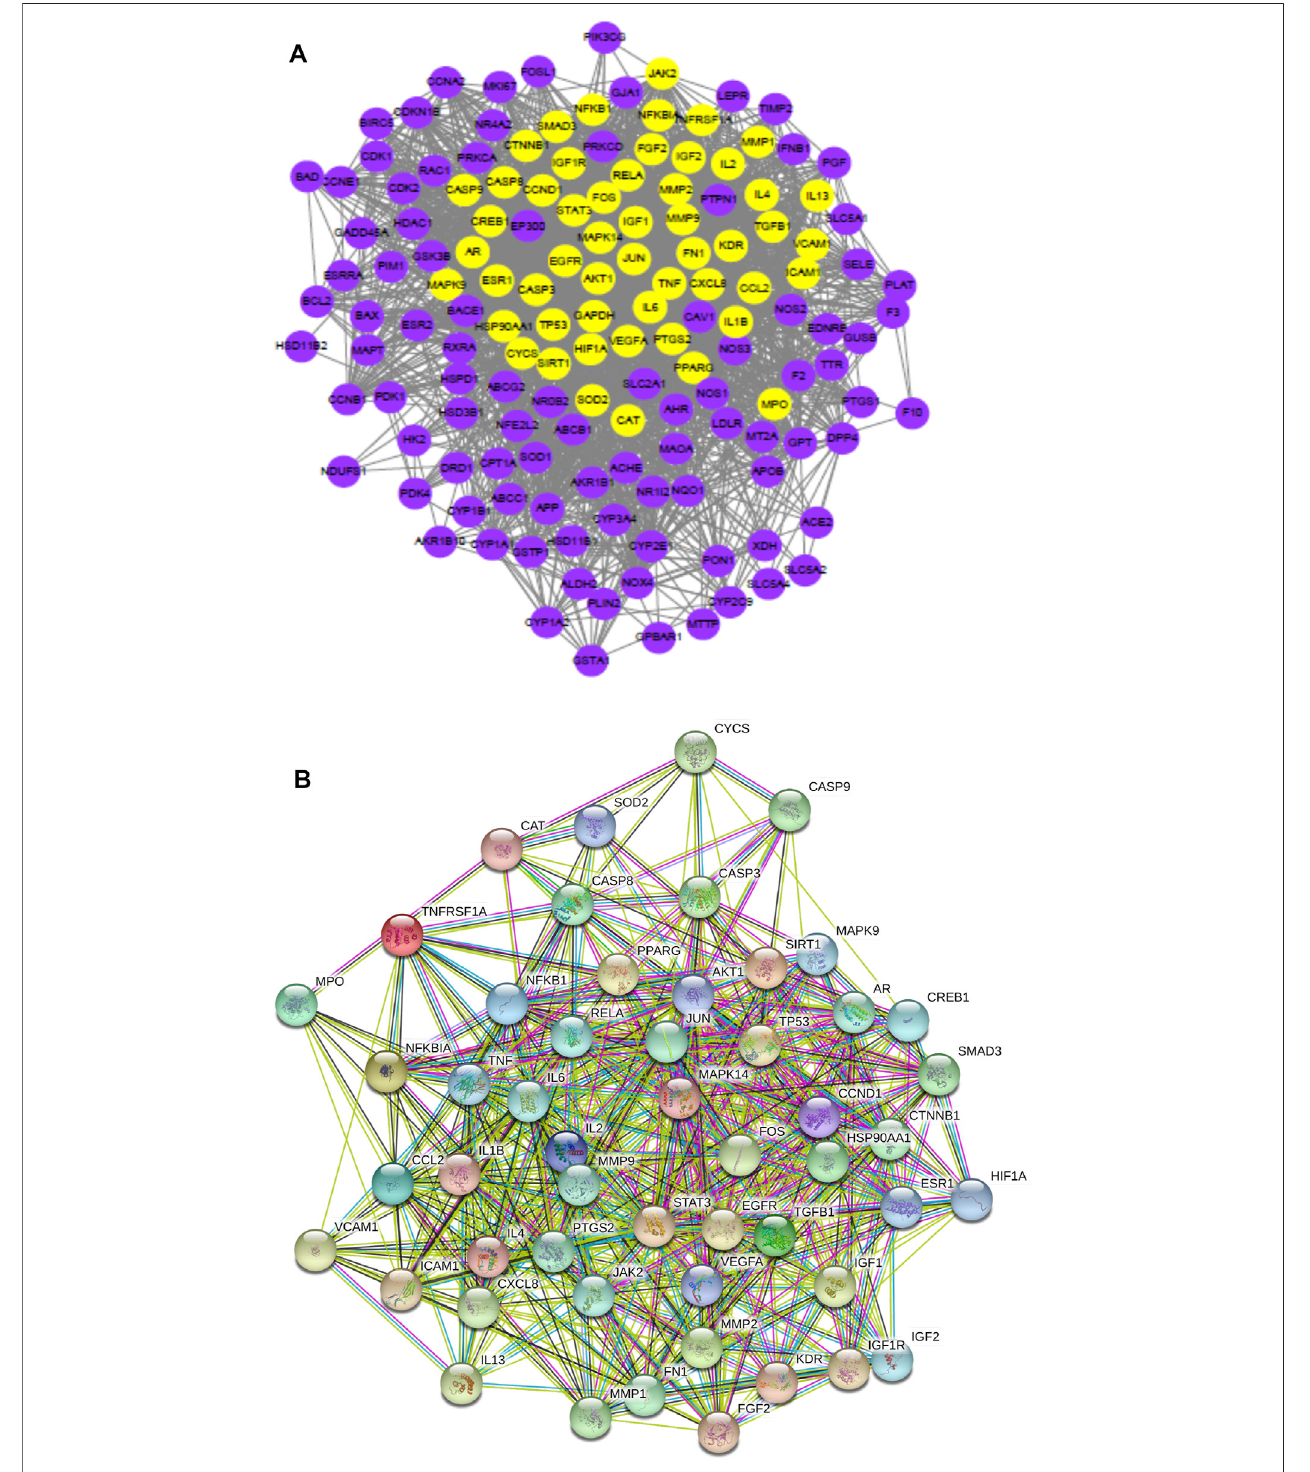
FIGURE2 |(A) Highly connectedsubnetworks (53 nodes, 1,120 edges) produced using Cytoscape 3.6.0, (B) aVenndiagram ofthe four herb compound-related gene numbers, and (C) protein – protein interaction network (52 nodes, 296 edges) produced using STRING.